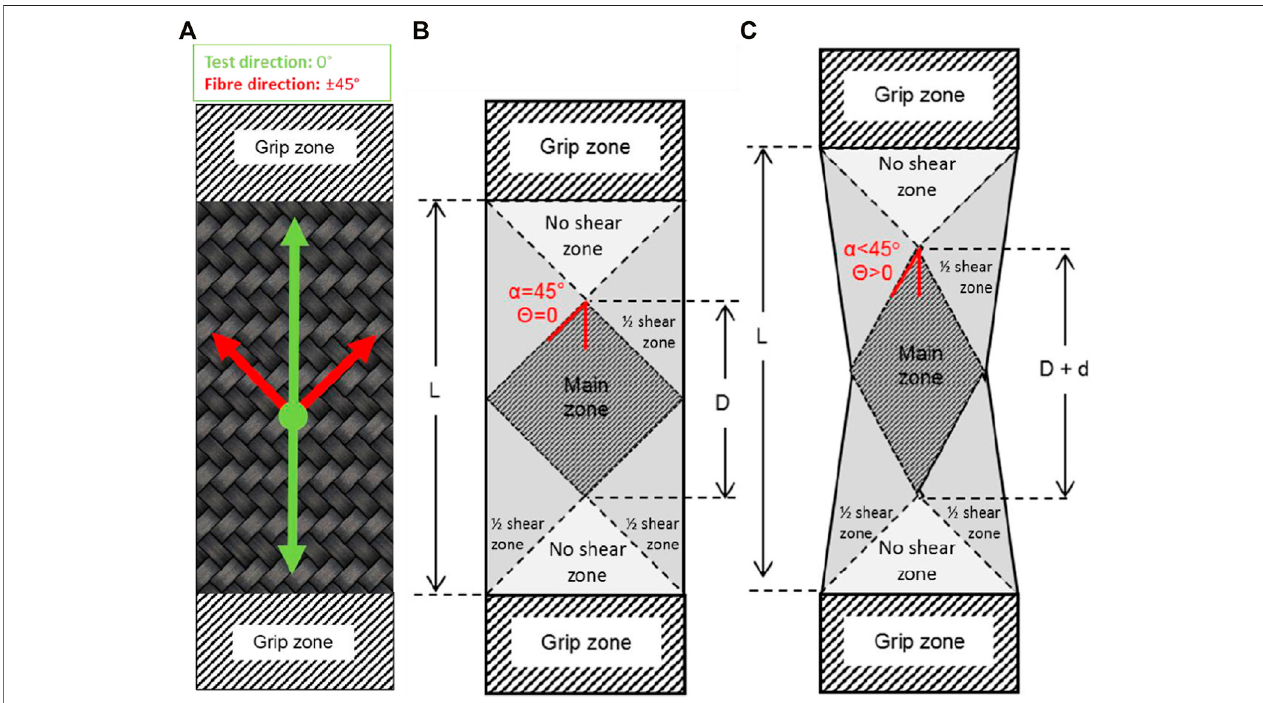
FIGURE 1 | (A) fi bre direction relative to load direction. (B) Undeformed specimen (C) Deformed sample during test